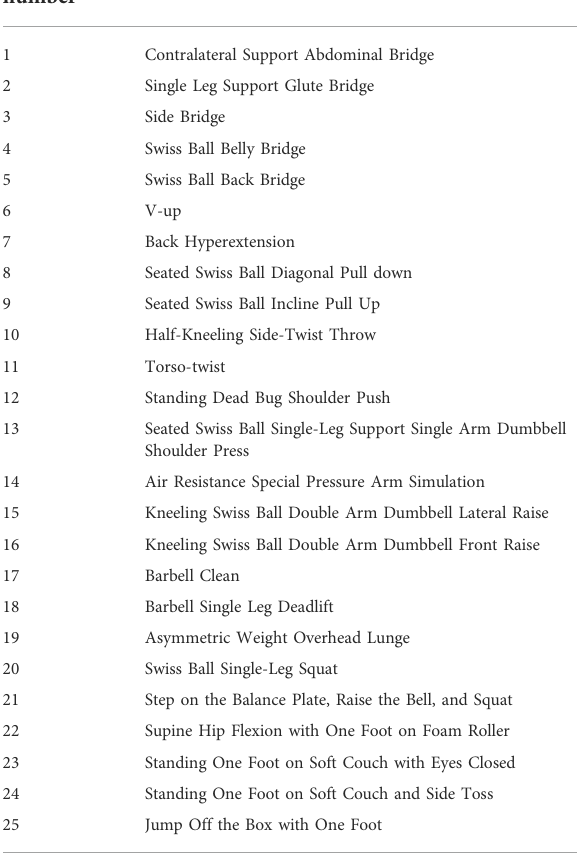
TABLE 1 Core stability training exercise.